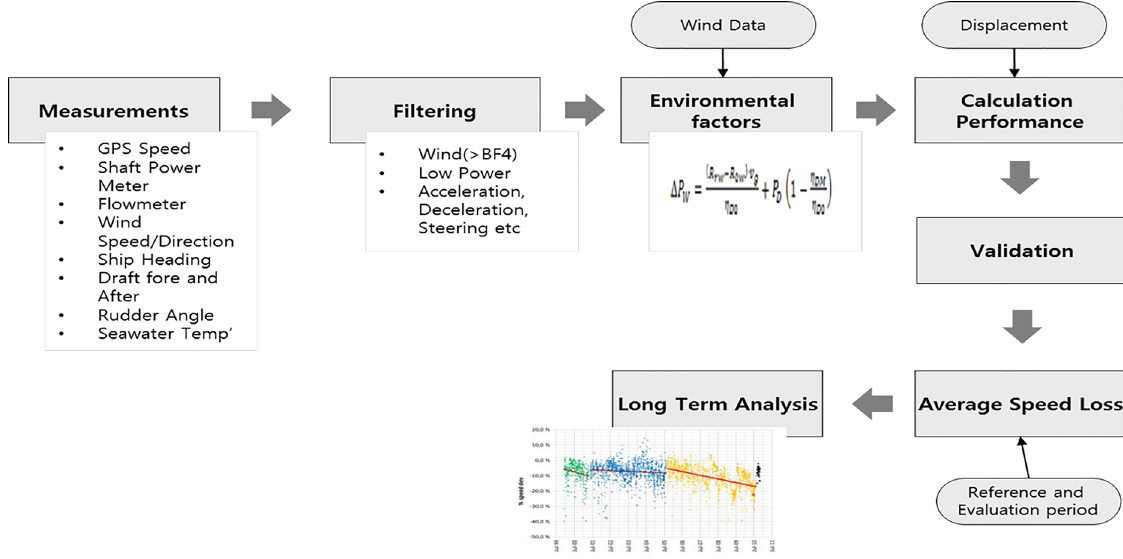
Figure 4. Measurement and analysis process of ISO19030.